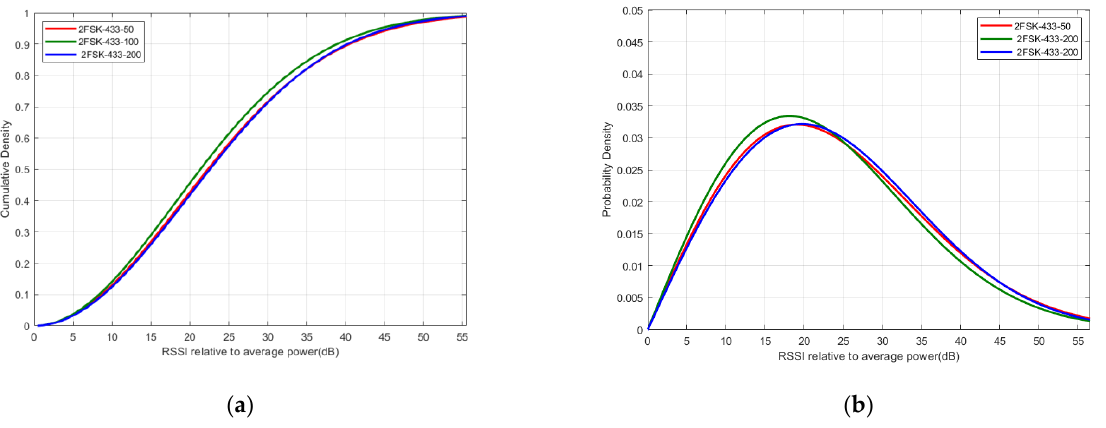
Figure 10. ( a ) CDF and ( b ) PDF of biased 2FSK 433.92 MHz multi-data rates Wi-SUN channel approximation (50, 100, 200 kbps).